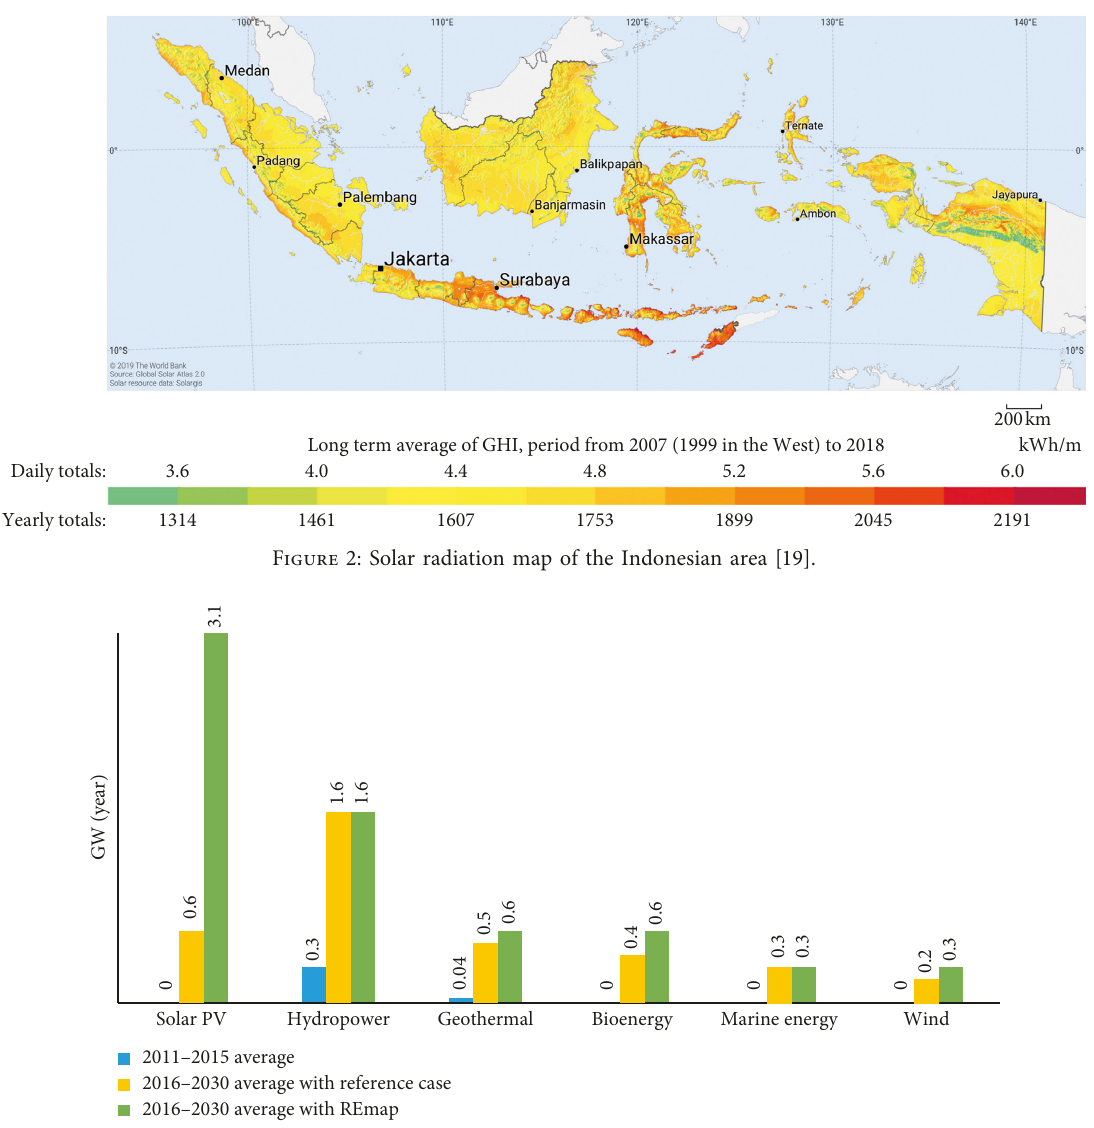
Figure 3: Annual renewable energy installations in 2011–2015 in the reference case of REmap for 2030 in Indonesia [20].